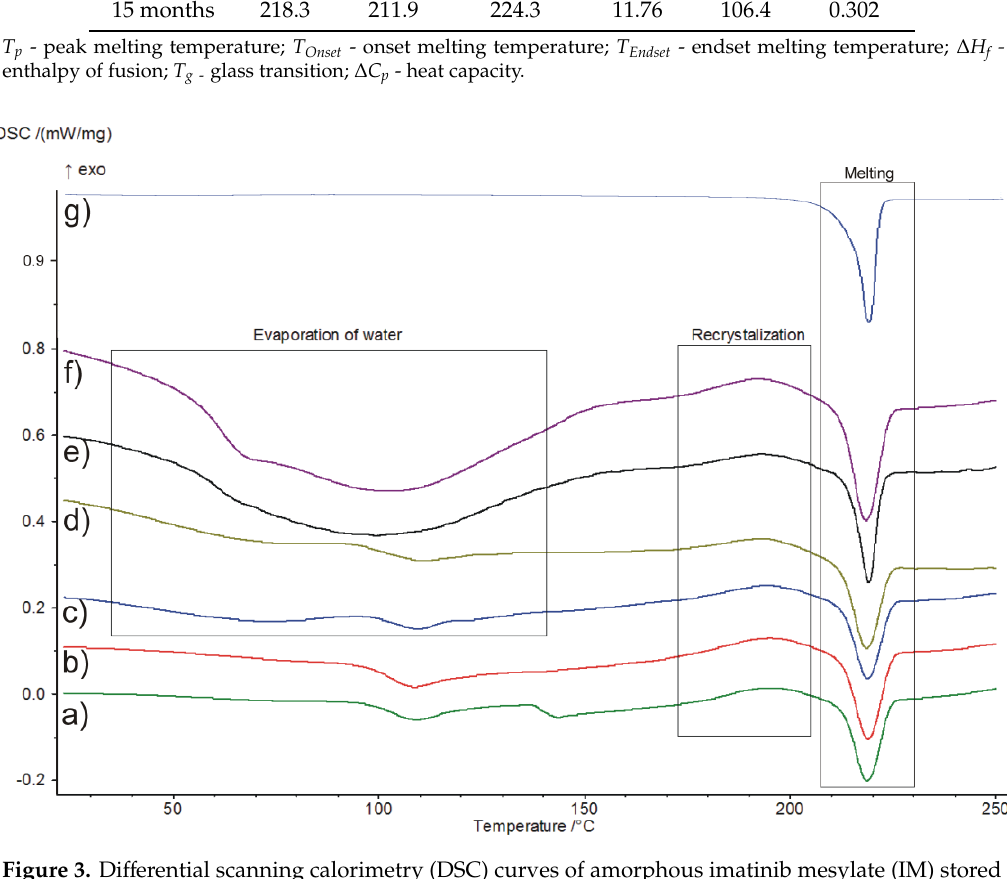
Figure 3. Di ff erential scanning calorimetry (DSC) curves of amorphous imatinib mesylate (IM) stored Figure 3. Differential scanning calorimetry (DSC) curves of amorphous imatinib mesylate (IM) at 25 ◦ C under controlled relative humidity at di ff erent ageing times: ( a ) day 0, ( b ) 2 weeks, ( c ) 1 month, stored at 25 °C under controlled relative humidity at different ageing times: ( a ) day 0, ( b ) 2 weeks, ( d ) 3 months, ( e ) 6 months, and ( f ) 15 months, and ( g ) crystalline ( c ) 1 month, ( d ) 3 months, ( e ) 6 months, and ( f ) 15 months, and ( g ) crystalline IM.